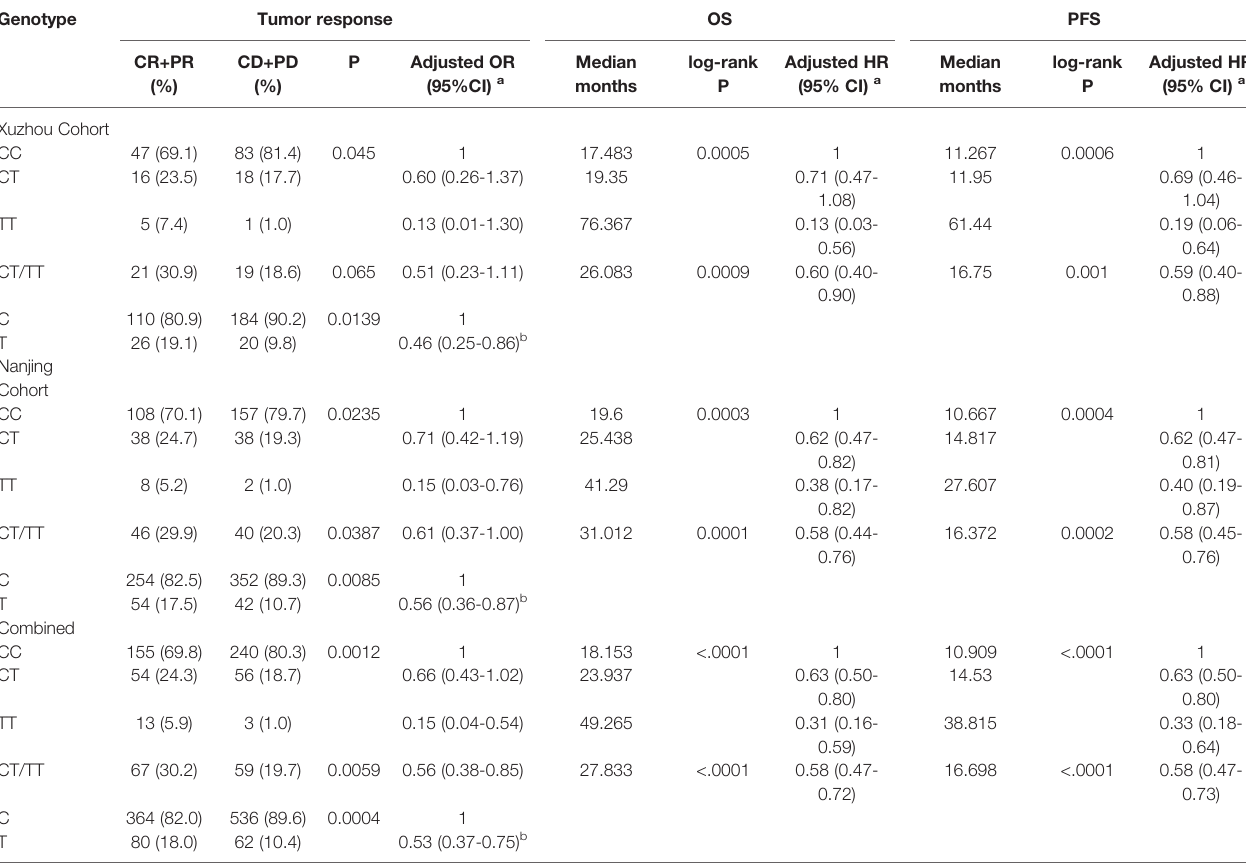
TABLE 2 | Association between PVT1 rs2278176 and colorectal cancer patient ’ s clinical outcome.